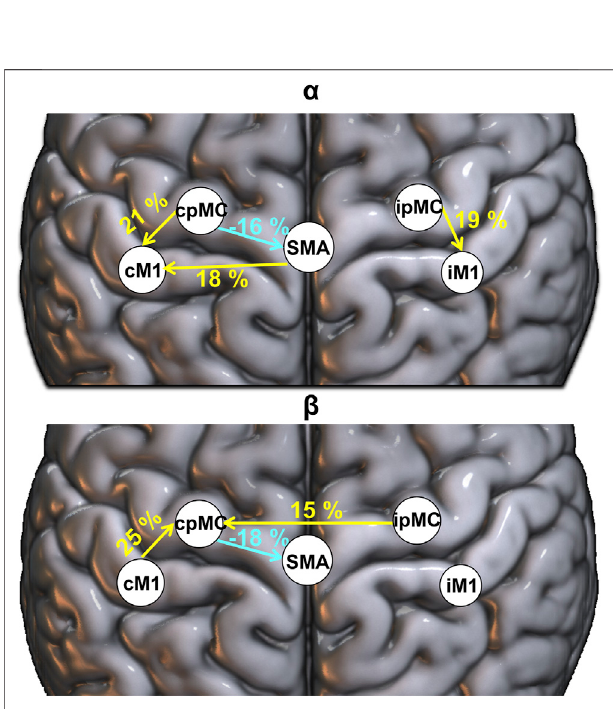
FIGURE 5 | Population ’ s signi fi cant Δ T1-T0 ICW connection in α (top panel) and β (bottom panel) frequency bands. Percentages: variation (T1-T0) in the proportion of signi fi cant subjects ’ connections (weighted for ICW), reported in yellow (greater number of signi fi cant connections is present in T1 with respect to T0) and light blue (smaller number of signi fi cant connections is present in T1 with respect to